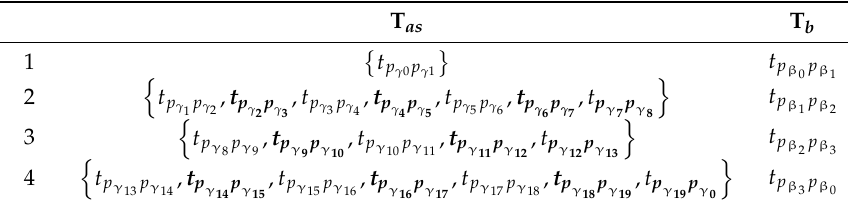
Table 1. Segmentation and classification of the shape